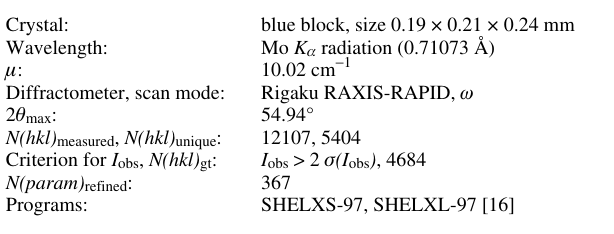
Table 1. Data collection and handling.